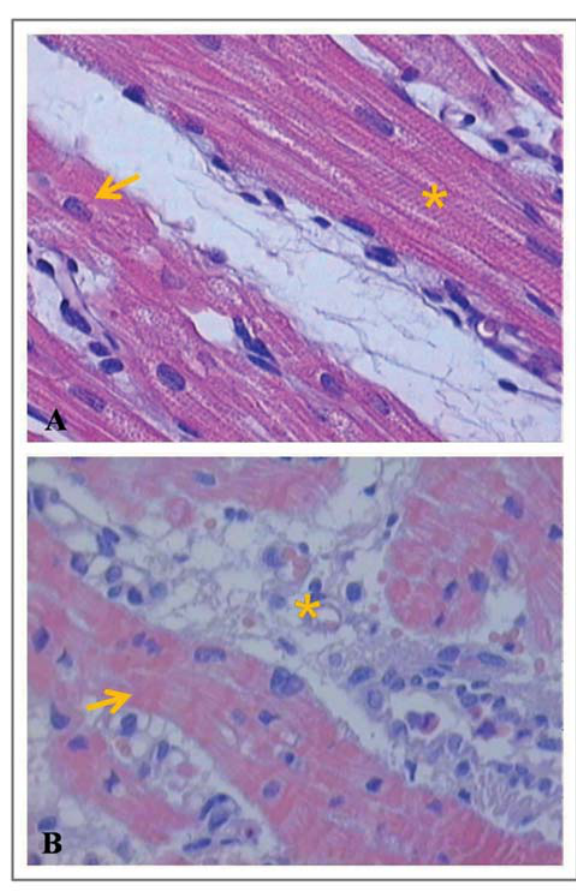
Fig. 1 – Comparação pós-operatória entre subgrupos do grupo I quanto às variáveis hemodinâmicas. IA – sem perfusão do tronco pulmonar; IB – perfusão do tronco pulmonar com sangue arterial; IC – perfusão do tronco pulmonar com sangue venoso; PAPM- pressão arterial pulmonar média em mmHg; RVP – resistência vascular pulmonar em dyne.s.cm 5